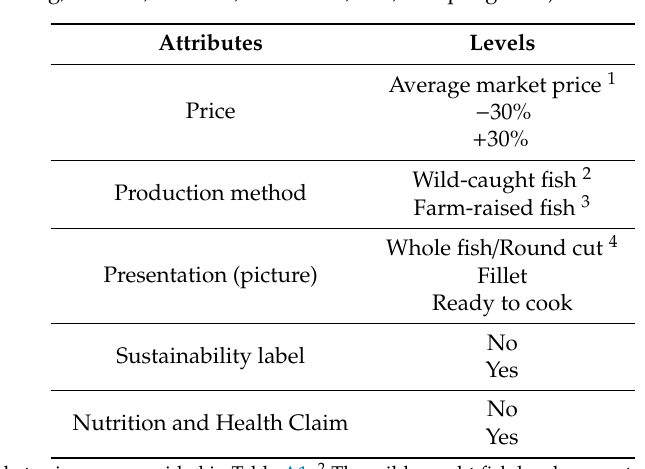
Figure 1. Example of a choice set. Table 1. Attributes and levels for the choice experiment in the five countries and for the seven fish species (trout, herring, salmon, sea bass, sea bream, cod, and